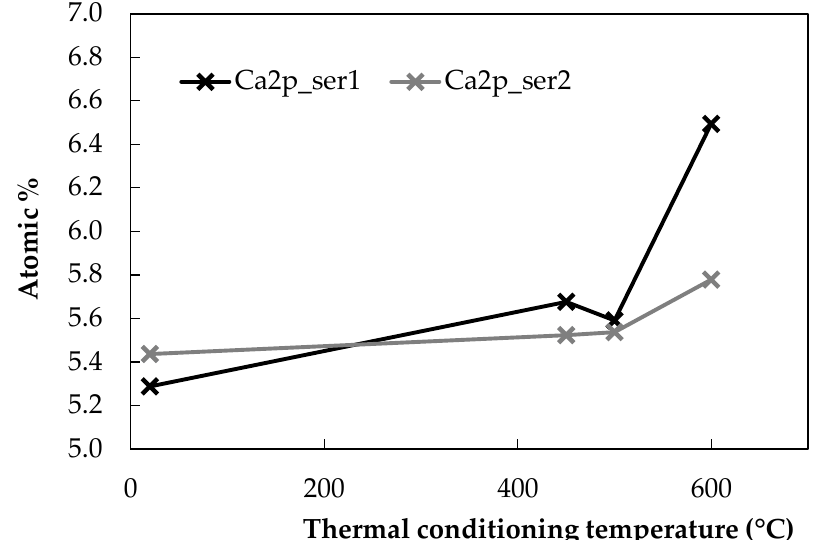
Figure 3. Atomic percentages of Ca at the E-glass surface with respect to the thermal conditioning temperature.